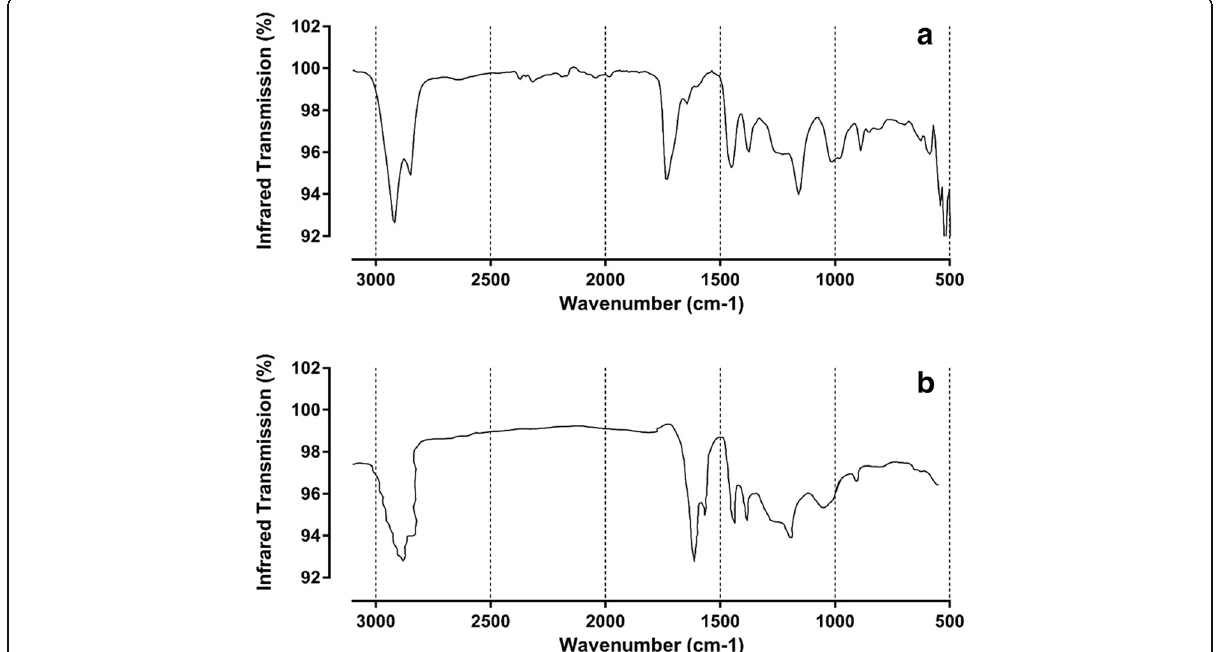
Fig. 1 Infrared spectrum of teething necklaces. a Crushed amber beads were analysed by infrared spectroscopy, measuring transmittance in the wavenumber range of 500 – 3100 cm − 1 . b Historical data on the infrared spectrum of Baltic amber was gathered from Beck et al (1956) [17] and adapted using the WebPlotDigitizer v3.21 tool for